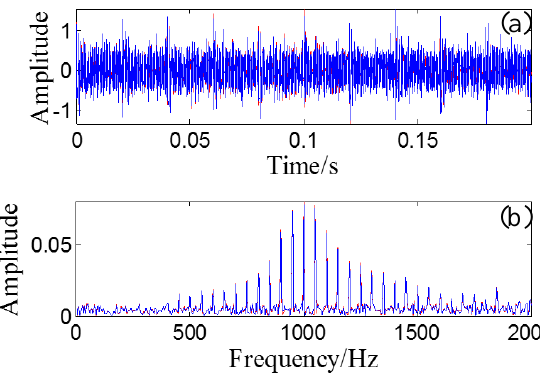
Figure 13. Comparison between the obtained Doppler-free signal and the original simulated bearing signal ( a ) wave form of the Doppler-free signal (red) and the original simulated bearing signal (blue); ( b ) FFT spectrum of the Doppler-free signal (red) and FFT spectrum of the original simulated bearing signal